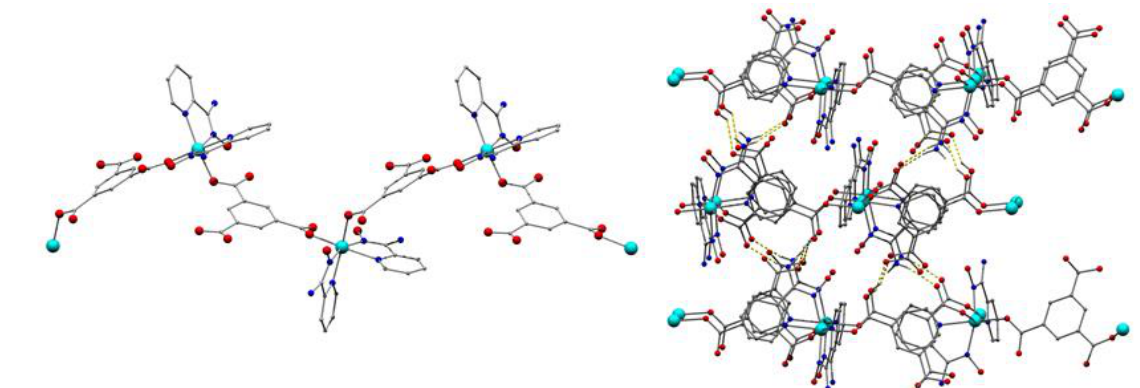
Figure 2. Representation of a part of the 1D chain in 2 ( left ) and the 3D network that is formed through intermolecular